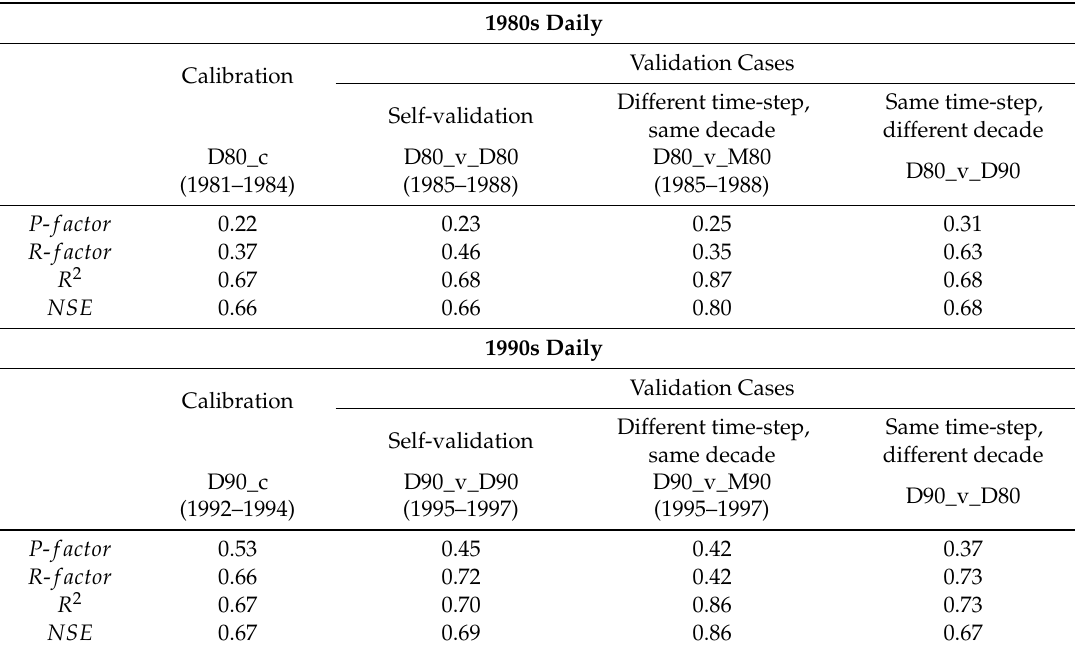
Table 5. Model calibration and validation performance for all calibration cases. ‘D80_c’ implies the calibration of the model using daily data from the 1980s decade, and ‘D80_v_M90’ implies the validation of the model calibrated using daily 1980s data on the 1990s monthly data. Years in parenthesis indicate the time period used in the particular calibration or